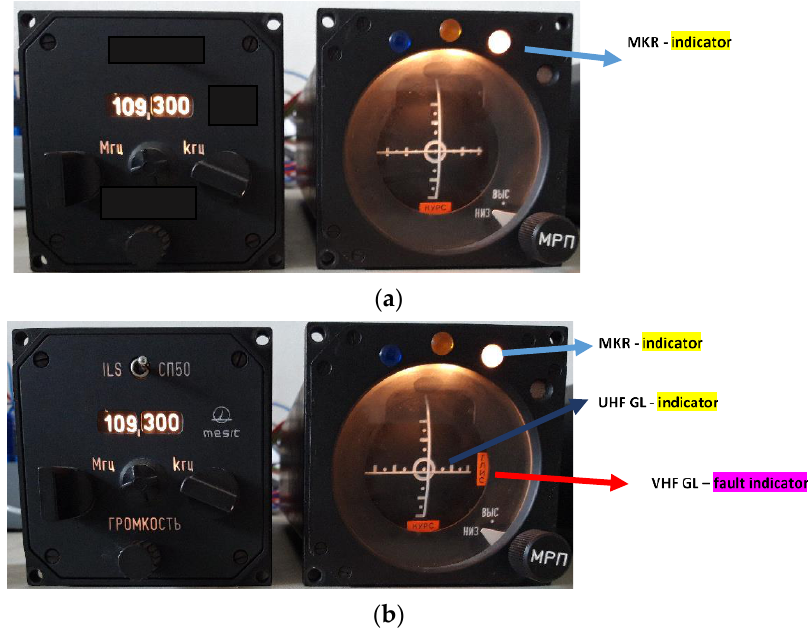
Figure 11. Disturbed marker (MKR) and GP channel of ILS receiver, ( a ) only inner marker interference, ( b ) disrupted GP receiver.